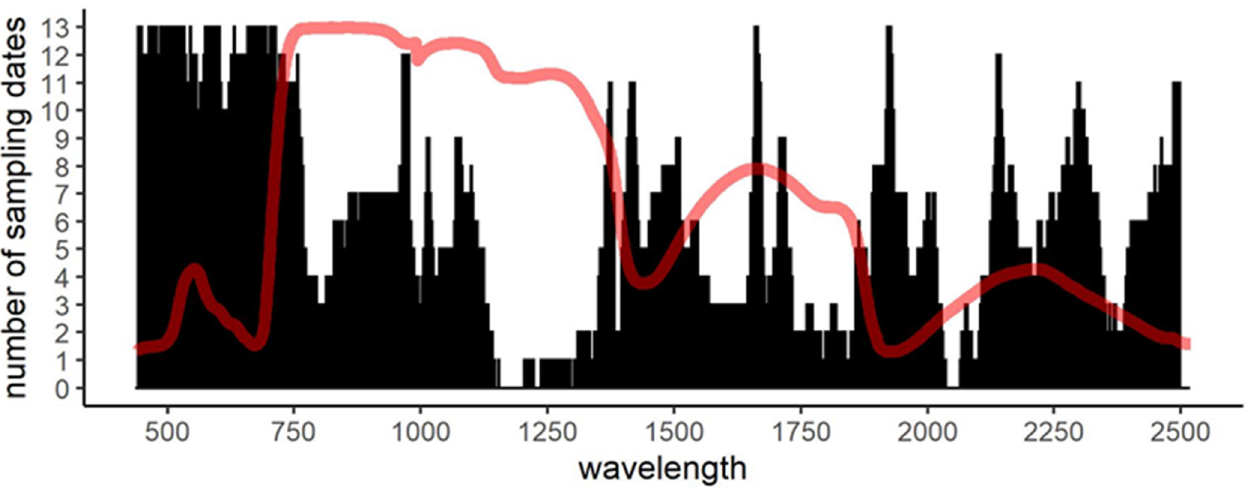
Figure 5. The number of times within each of the 13 sampling dates that wavebands were consistently selected in all model runs. A reference leaf spectrum (red line) is superimposed on the plot for contextualisation.